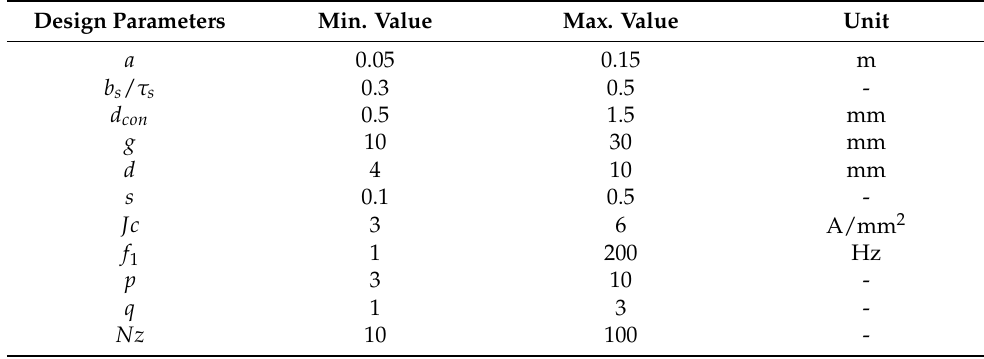
Table 2. Search range of design parameters of SP-DLIM. Design